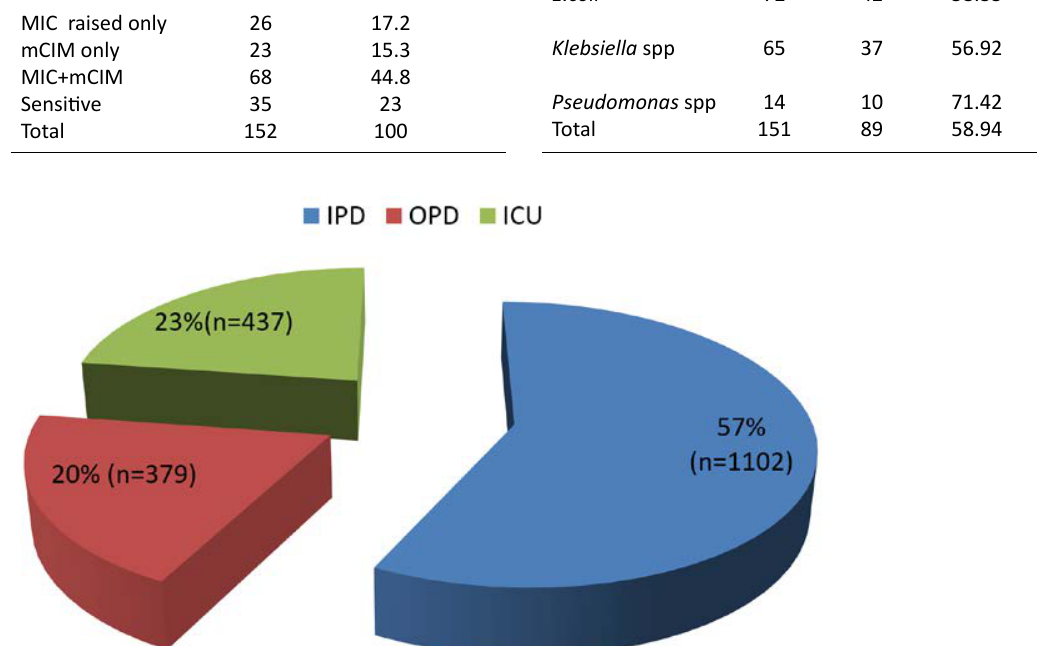
Table 5. Carbapenem profile of isolates Resitance profile